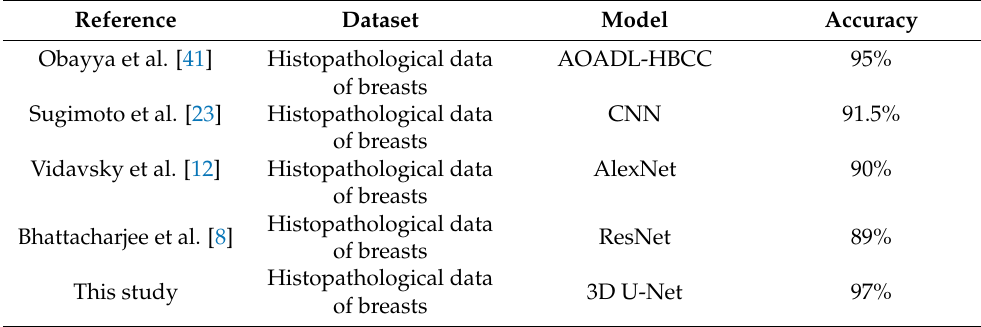
Table 2. Detailed comparison of prior advanced studies and the proposed work for the classification of invasive ductal